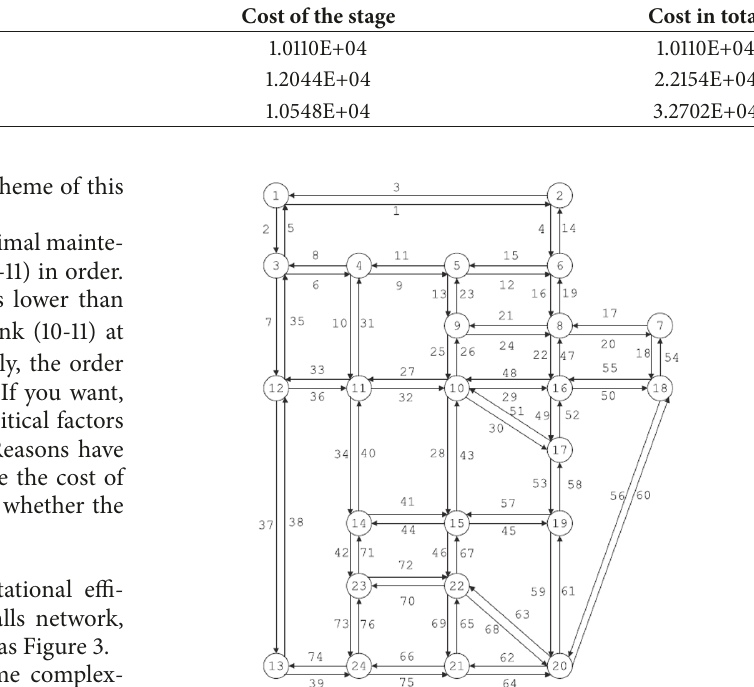
Table 3: Optimal maintenance scheme of the Nguyen-Dupuis network.